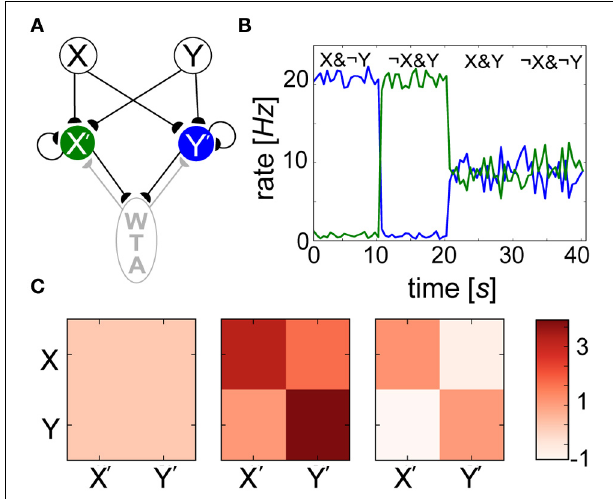
FIGURE 10 | Spiking BCPNN performs a simple Bayesian inference. (A) Network architecture with excitatory (black) and inhibitory (gray) connections between local minicolumns. Input neurons of groups X and Y each project to the output layer X (cid:9) (green) and Y (cid:9) (blue), which mutually inhibit each other via an inhibitory WTA population (gray). (B) Posterior probability distributions are reflected by the output rates of postsynaptic neuron pools X (cid:9) and Y (cid:9) (colors corresponding to A ) in 1s bins during recall. (C) Evolution of the mean weight matrix during training, where each cell represents the averaged activity for all 900 connections. Three snapshots were taken during learning: one at the beginning, one a tenth of the way through, and one at the end of the simulation. Weights that were developed in alternating 200ms intervals were initially volatile, but eventually settled into a symmetrical terminal weight